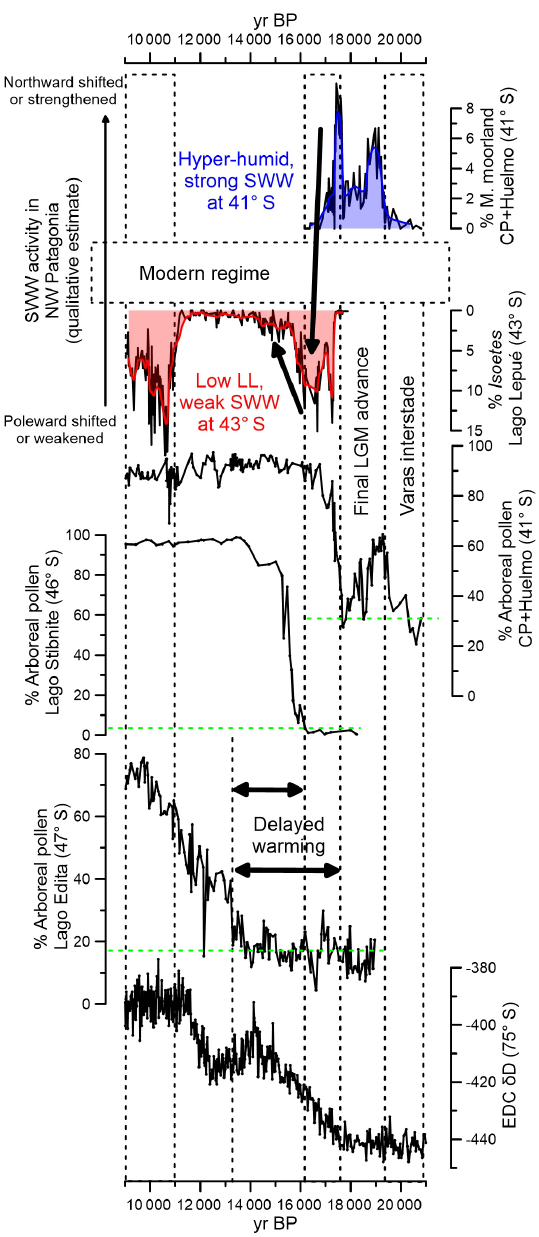
Figure 8. Comparison of the percent sum of arboreal pollen (AP) in records from Lago Edita, Lago Stibnite (Lumley and Switsur, 1993) and the spliced Canal de la Puntilla-Huelmo time series (Moreno et al., 2015), as proxies for local rise in tree line driven by deglacial warming. These data are compared to the delta Deuterium record from the EPICA Dome Concordia (EDC) ice core (Stenni et al., 2010), and hydrologic estimates from northwestern Patagonia. The latter consist of the percent abundance of Magellanic moorland species found in the spliced Canal de la Puntilla-Huelmo record (Moreno et al., 2015), indicative of a hyper-humid regime, and the percent abundance of the littoral macrophyte Isoetes savatieri from Lago Lepué (Pesce and Moreno, 2014), indicative of low lake level (LL) during the earliest stages of T1 and the early Holocene (9000–11000yrBP). The vertical dashed lines constrain the timing of the early Holocene SWW minimum at 41–43 ◦ S (9000–11000yrBP) (Fletcher and Moreno, 2011), a low-precipitation phase during the early termination at 41–43 ◦ S (16800– 17800yrBP) associated with a southward shift of the SWW (Pesce and Moreno, 2014), the final LGM advance of piedmont glacier lobes (17800–19300yrBP) and the final portion of the Varas interestade (19300–21000yrBP) in the Chilean Lake District (Denton et al., 1999; Moreno et al., 2015). The dashed green horizontal lines indicate the mean AP of each pollen record prior to their increases during T1 (Lago Edita: 17%, Lago Stibnite: 2%, spliced Canal de la Puntilla-Huelmo: 31%). The ascending oblique arrow represents a northward shift of the SWW the descending arrow represents a southward shift of the SWW at the beginning of